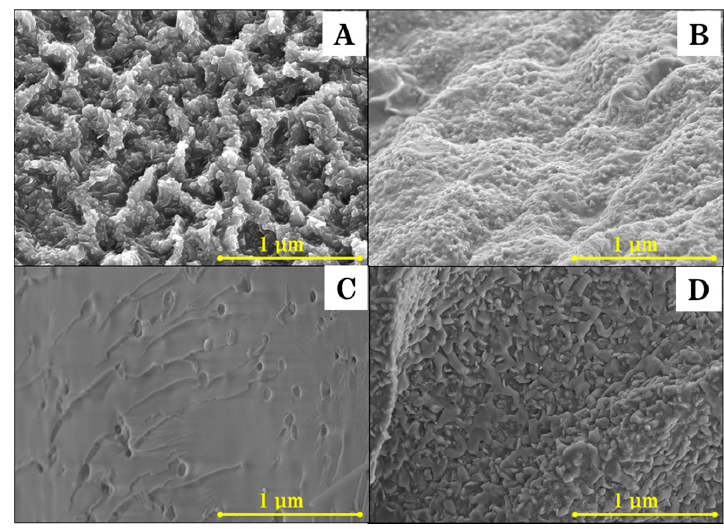
Figure 1. Field-emission scanning electron microscope (FE-SEM) images of ( A ) G/PANI/FG1; ( B ) G/PANI/FG2; ( C ) G/PANI/FG3; and ( D ) PANI/GNG.